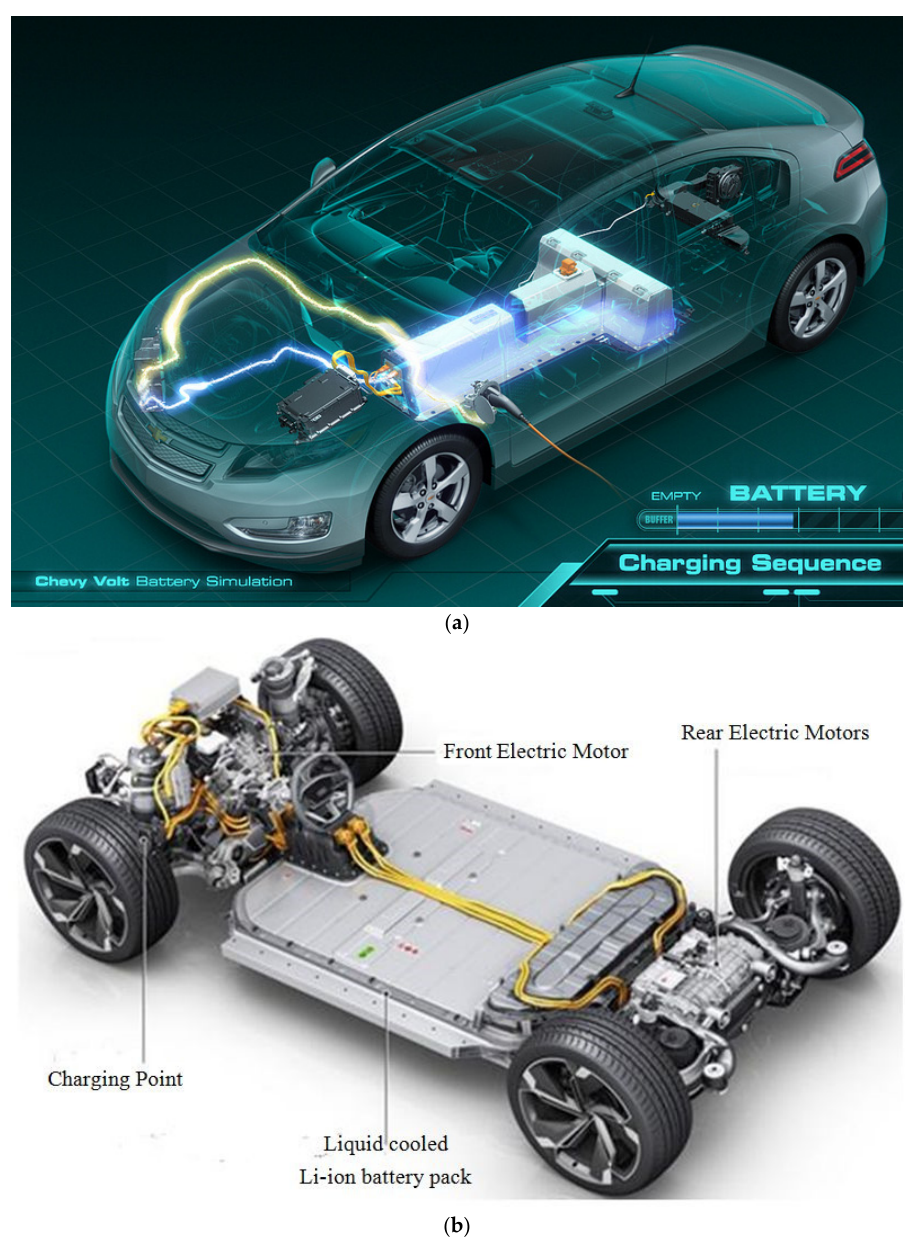
Figure 7. Battery Packaging architectures ( a ) T ‐ shaped architecture used in GM Chevrolet Volt [73] and ( b ) Floor architecture used in Audi e ‐ tron Sportsback concept [74]. ( b ) Floor architecture used in Audi e-tron Sportsback concept